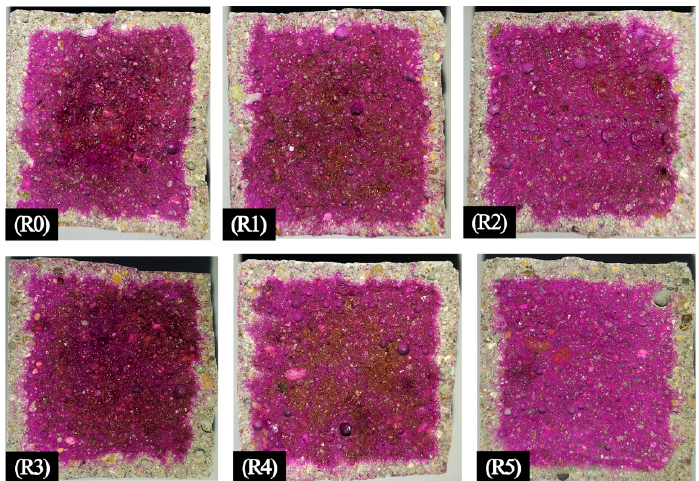
Figure 2. Image of carbonation depth under mechanical agitation (3 d) .